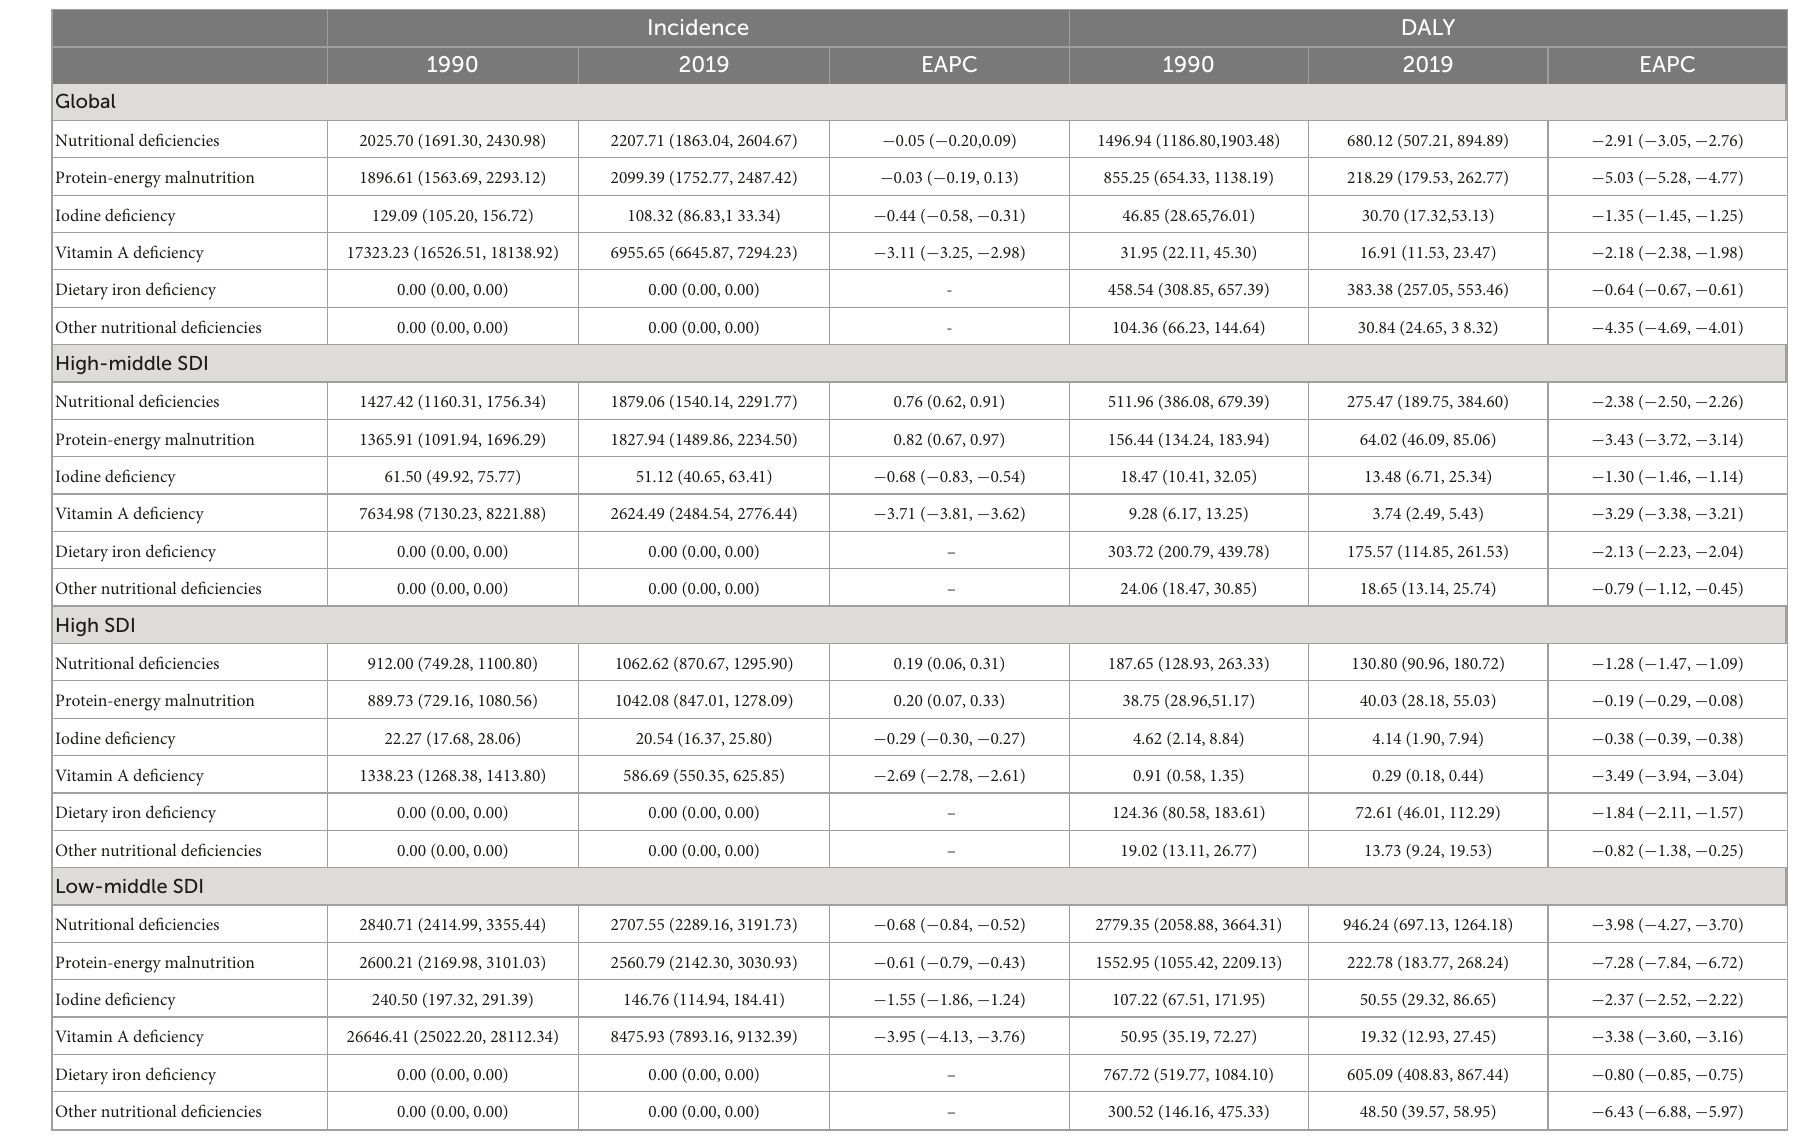
TABLE 1 Age-standardized incidence rates for nutritional deficiency (including subcategories) and their estimated annual percentage changes (EAPC) in low-and middle-income countries (LMIC) by sex group,